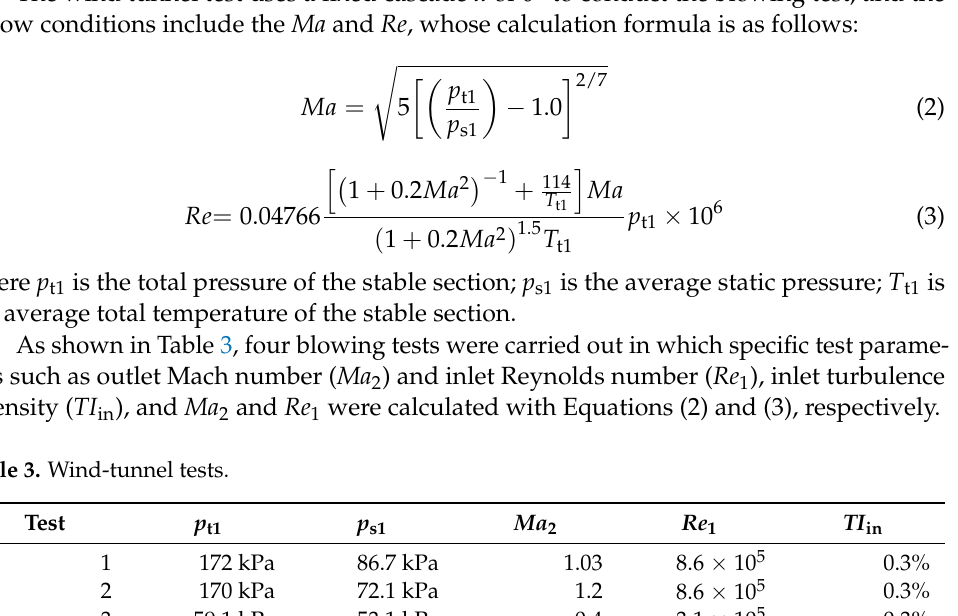
Figure 3. Schematic diagram of blade coating and blade shape. ( a ) TSP coating structure; ( b ) dimensional marking of blade shape.